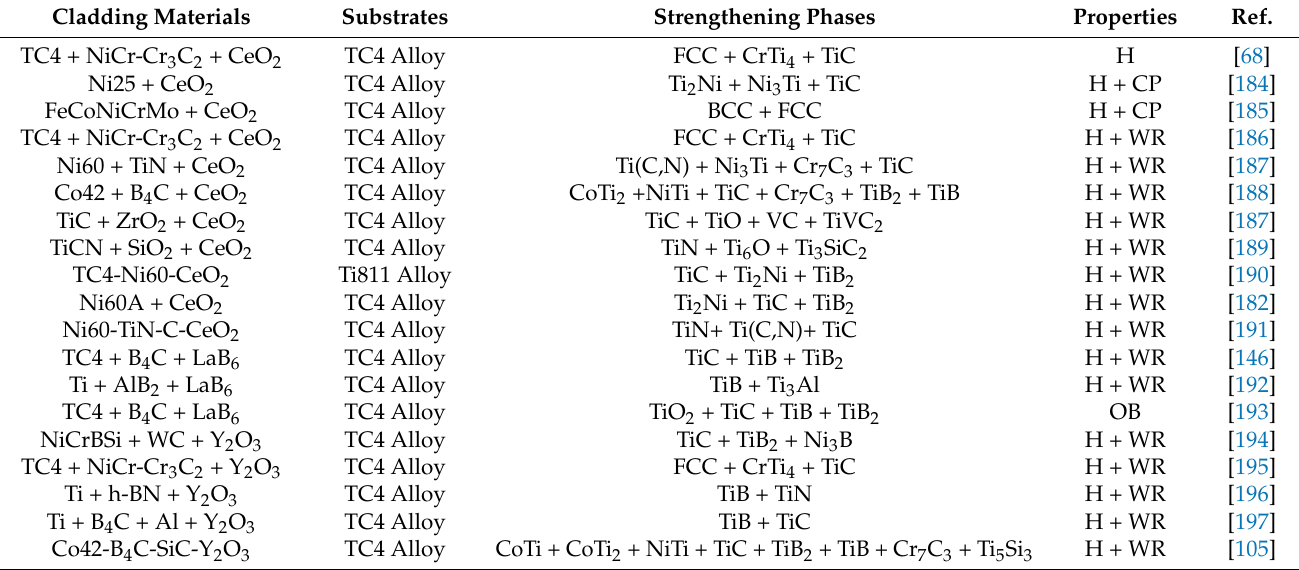
Table 5. The rare-earth-doped powders for the surface modification of Ti-based alloys by LC. Cladding Materials Substrates Strengthening Phases